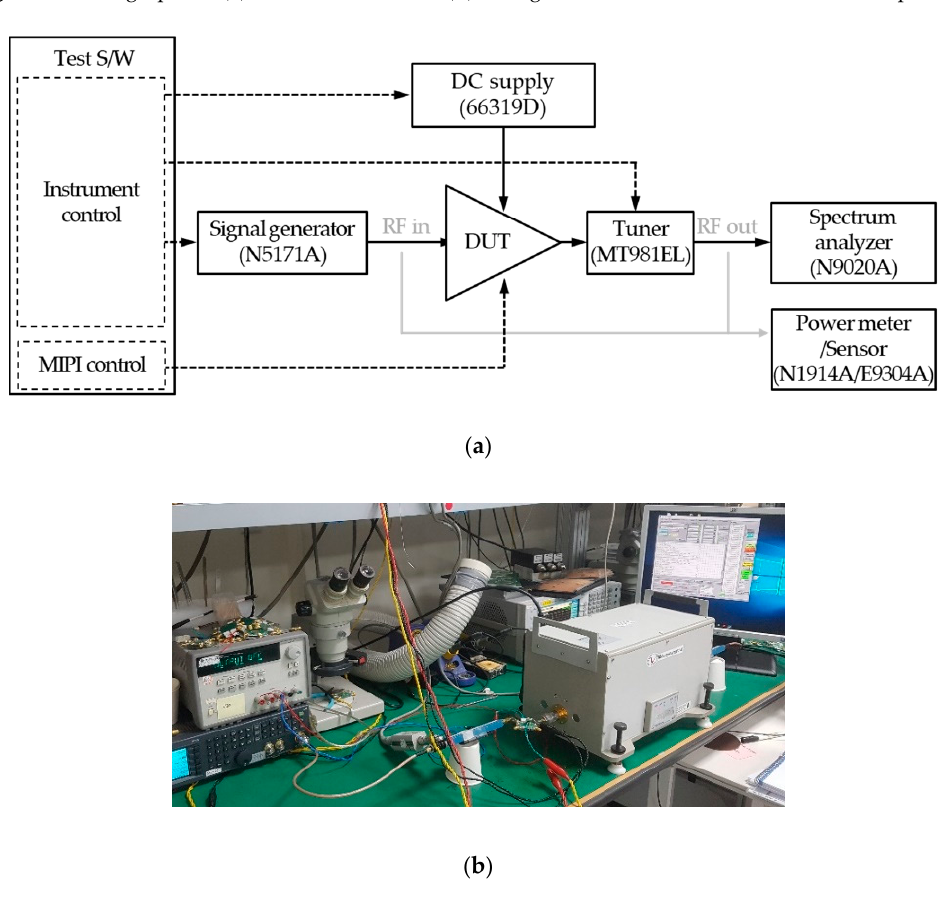
Figure 9. Measurement setup for ruggedness test. ( a ) Block diagram of test setup; ( b ) photograph of the measurement setup.